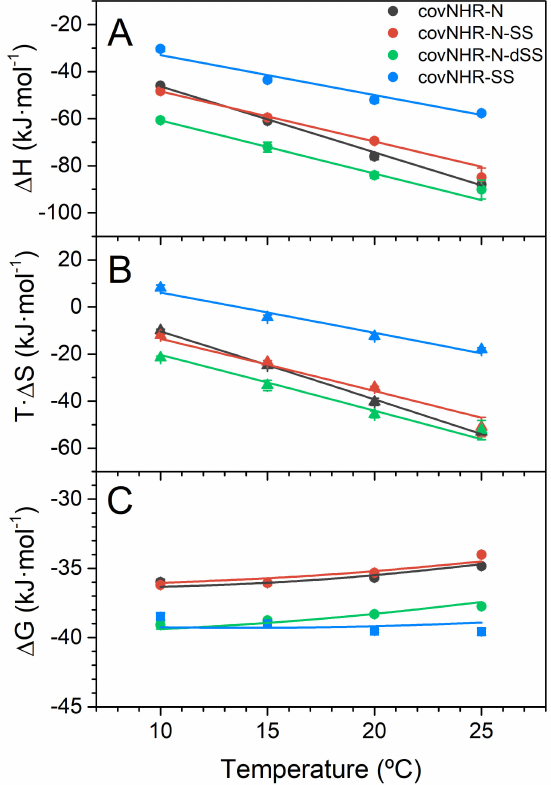
Figure 4. Thermodynamic parameters of Y24L peptide binding to the covNHR proteins. Data have been calculated from the parameters of Table 1 and data from [24], measured by isothermal titration calorimetry (ITC) ( A ) Binding enthalpies; ( B ) binding entropies and ( C ) binding Gibb’s energies. The symbols correspond to the values derived from experimental data and the lines represent the temperature dependencies of each parameter according to the binding heat capacity